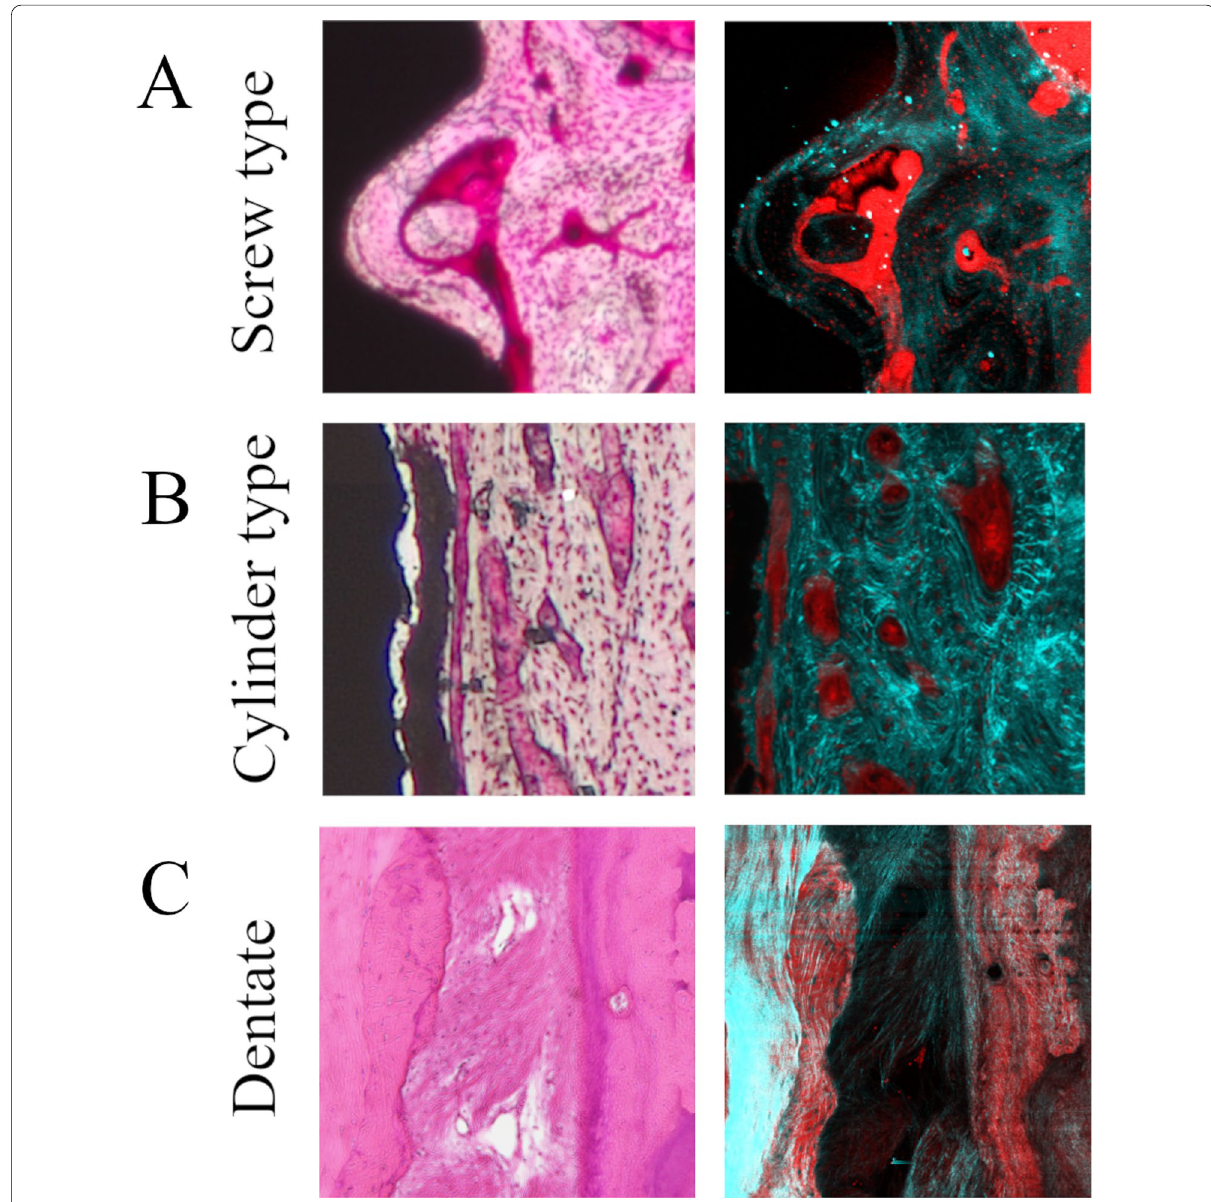
Fig. 4 Bulk-stained osteonal bone in the vicinity of the implant and collagen fibers running in the interior. A Screw type. B Cylinder type. C